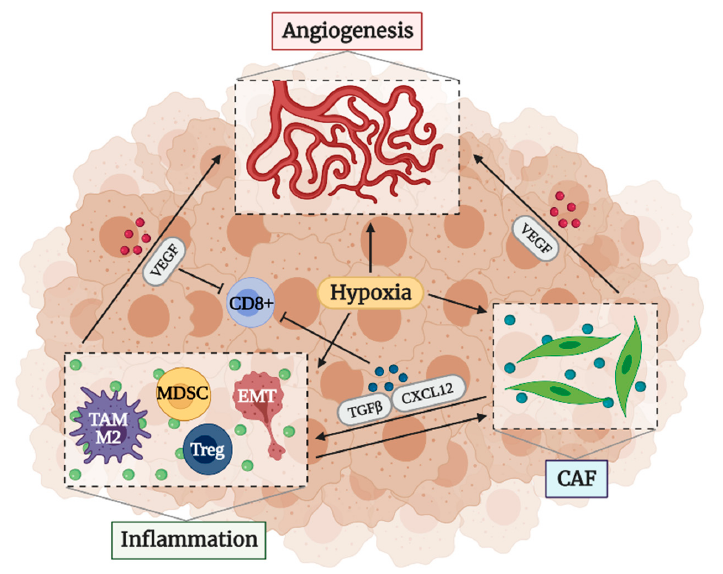
Figure 2. Factors that determine an immunosuppressive TME: angiogenesis, inflammation, and CAFs . Inflammatory cells and CAFs stimulate angiogenesis by releasing proangiogenic factors such as vascular endothelial growth factor (VEGF), which also suppress the activity and recruitment of effector cells. Moreover, CAFs also suppress the recruitment of cytotoxic T cells by liberating immunosuppressive ligands and promote the recruitment of other suppressor cells that activate CAFs in turn. On the other hand, hypoxia stimulates angiogenesis, participates with CAFs to maintain the stemness of cancer cells, and induces the recruitment of different types of immunosuppressive cells. Created with BioRender.com.